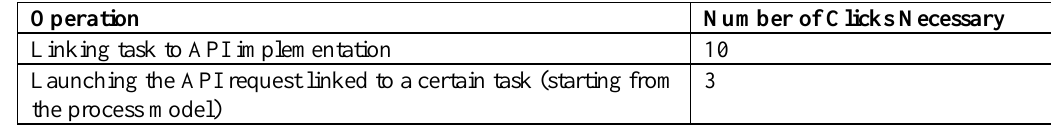
Table 3. Modeling effort for linking APIs to processes and launching API